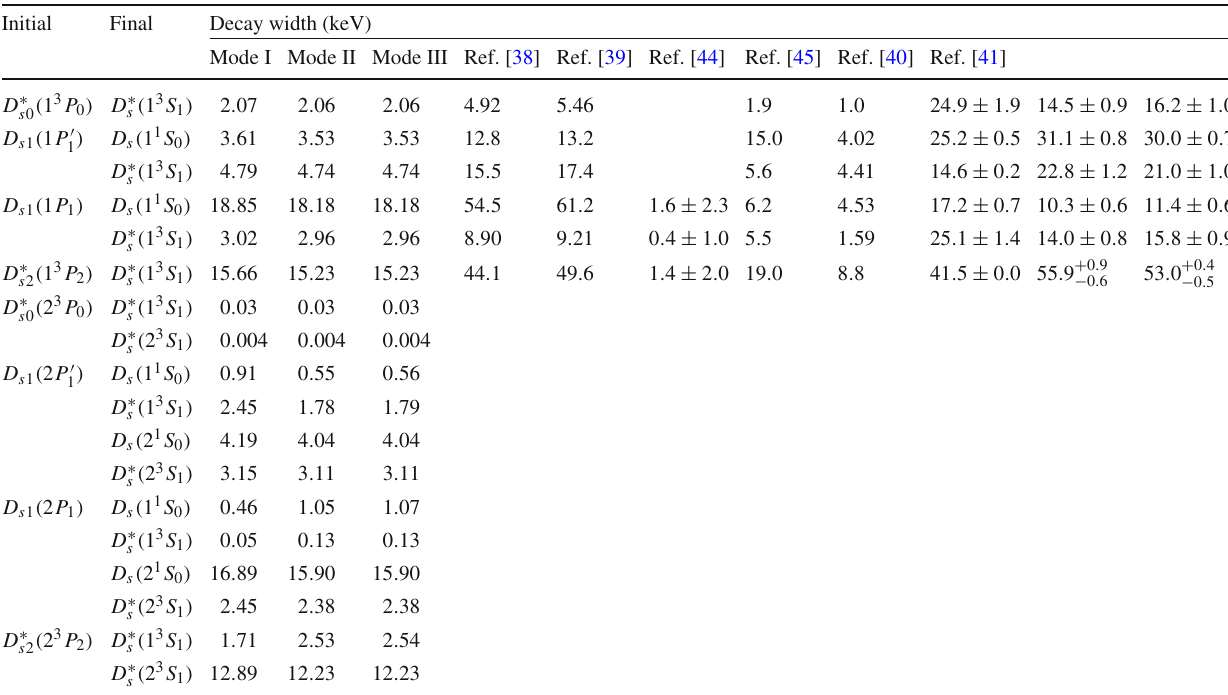
Table 4 The same as Table 3 but for P → S γ processes. For comparison, we also present the theoretical estimations from Refs. [38–41,44,45]. The results of Ref. [40] are estimated with the mixing angle θ 1 P = − 38 ◦ [42,43] Initial Final Decay width (keV) Mode I Mode II Mode III Ref. [38] Ref. [39] Ref. [44] Ref. [45] Ref. [40] Ref. [41]